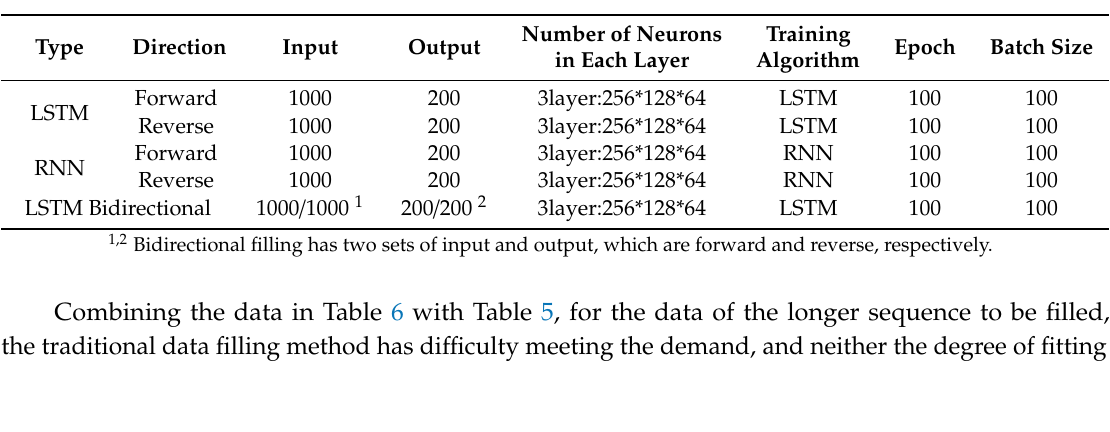
Table 7. Summary table of all model